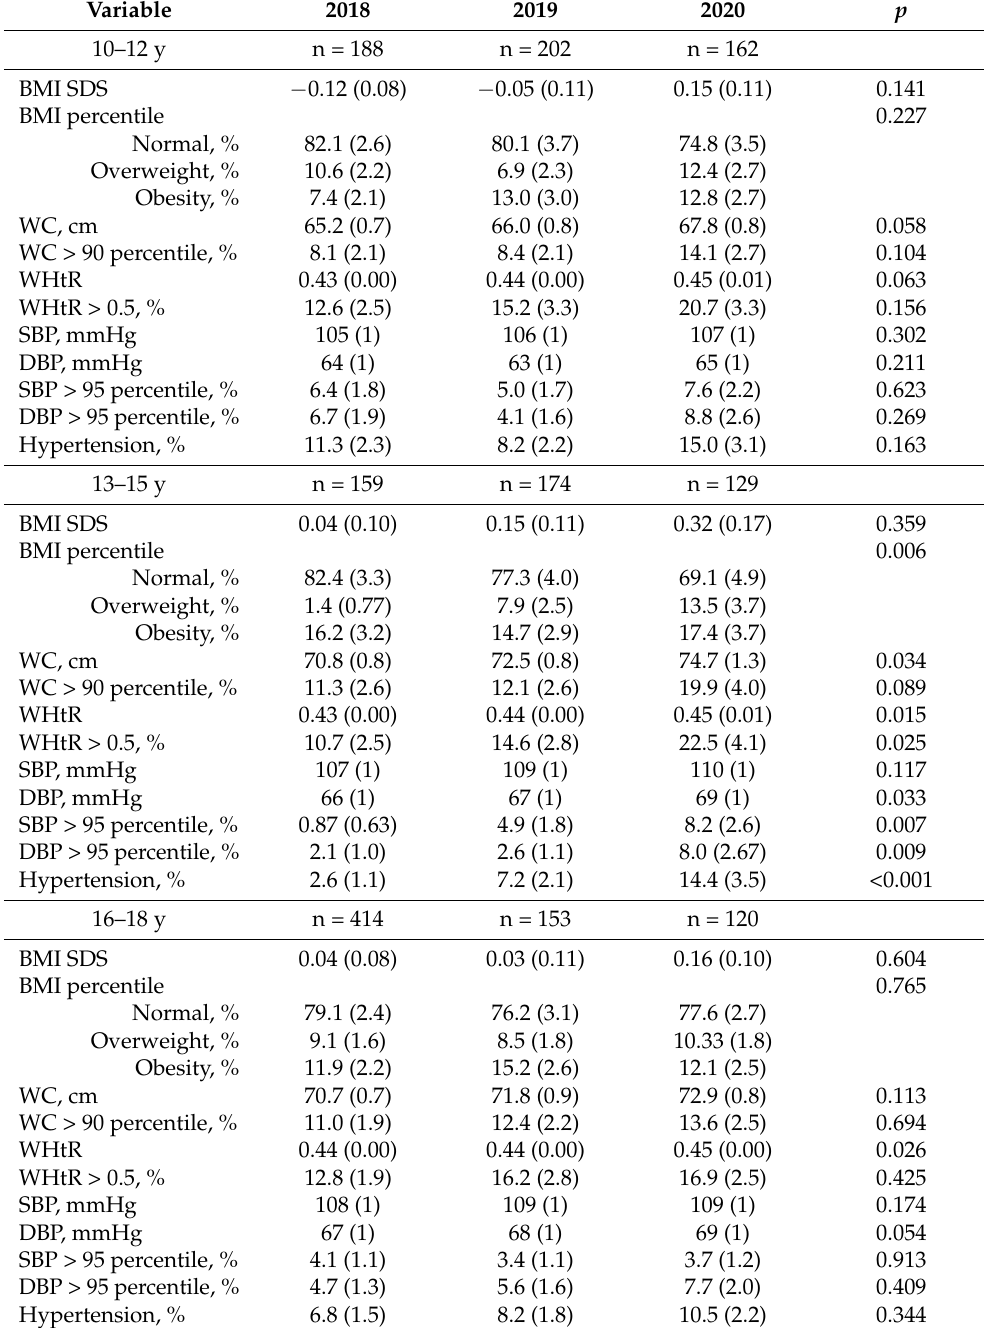
Table 3. Proportion of participants with obesity, abdominal obesity, and hypertension according to age